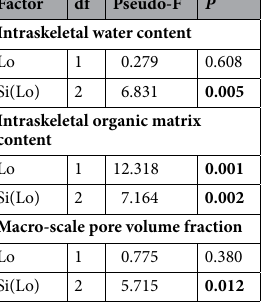
Table 4. Results of the PERMANOVA analysis for intraskeletal water and organic matrix (OM) content and macro-scale pore fraction volume in Pocillopora damicornis in control and seep sites at Dobu and Upa Upasina. Lo location, Si